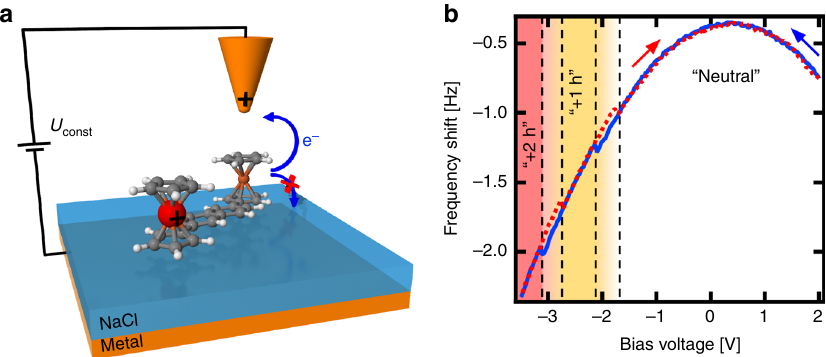
Fig. 1 Charging of the molecule. a Schematic view of the experimental setup, showing the de fi nition of the sample voltage U , transport of electrons into the tip as well as within an adsorbed molecule. Thick layer of NaCl prevents tunneling current between bisFc molecules and the metallic substrate. b Charging parabola (blue solid line) taken above a bisFc molecule. Jumps in the parabola denote the extraction of an electron from the bisFc molecule, which brings the molecule to the once ( U = − 2.1 V) and twice ( U = − 3.1 V) positively charged states (light orange and light red regions). Discharging parabola (red dotted line) jumps are shifted in comparison with charging ones, creating hysteresis of charging. Jumps in parabola denote insertion of an electron to the bisFc molecule, which brings the molecule to the once positively charged ( U = − 2.8 V) and neutral states ( U = − 1.8